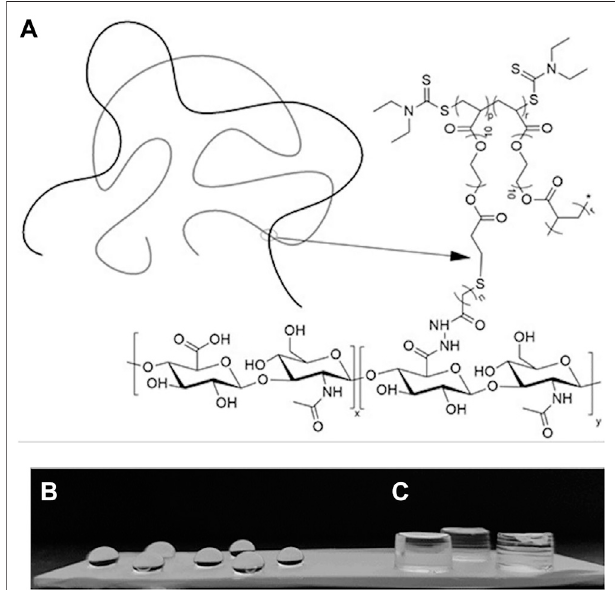
FIGURE 2 | (A) : Schematic representation of the formation of a HB PEGDA/HA-SH hydrogel by thiol – ene cross-linking mechanism. (B) : HB PEGDA/HA-SH 10.0 – 1.0 hydrogel beads (30 μ L) on the Te fl on ™ plate surface. (C) : HB PEGDA/HA-SH 10.0 – 1.0 hydrogels (200 μ L) with cylindricalshapeobtainedbyhydrogelcross-linkinginaconvenientmold.( p (cid:2) 0.45) ( r (cid:2) 0.55) ( n (cid:2) 2) ( x (cid:2) 0.58) and ( y (cid:2)